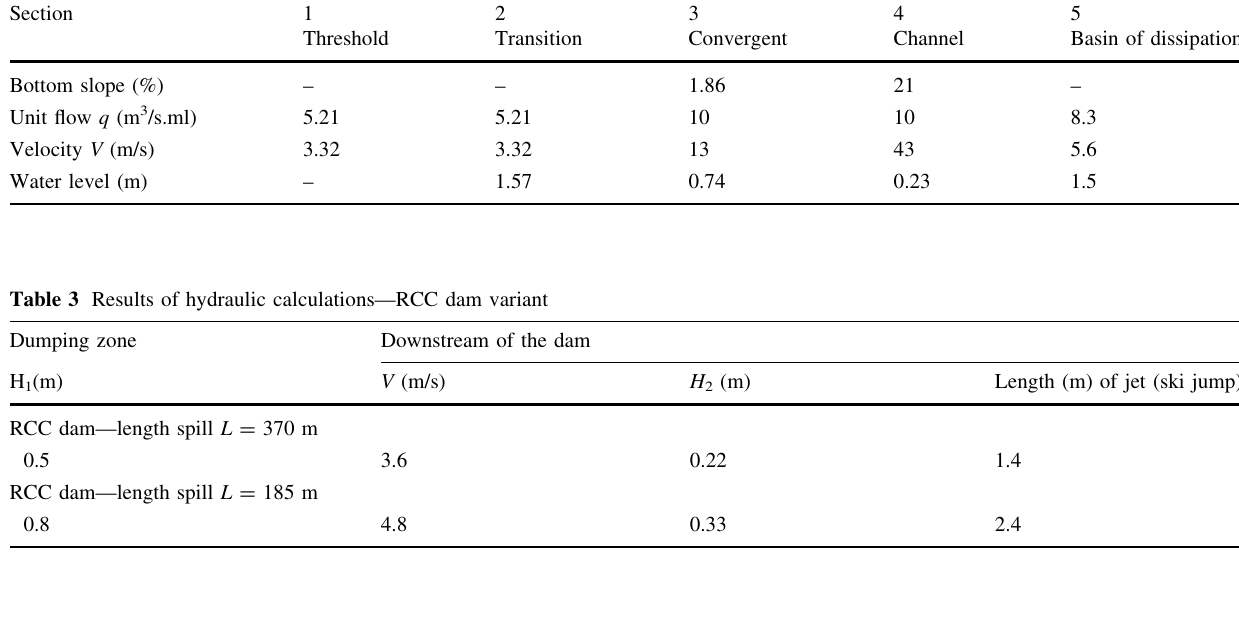
Table 2 Results of hydraulic calculations—frontal spillway variant Section